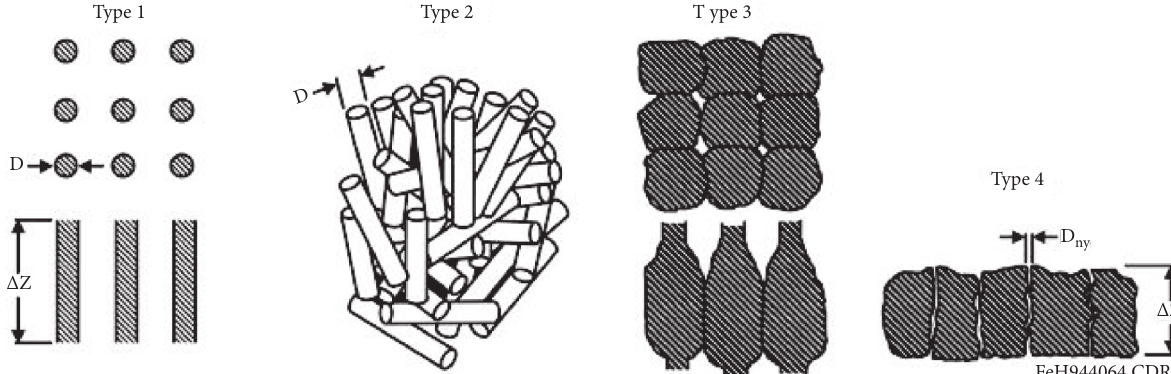
Figure 1: MAAP core geometry during melt